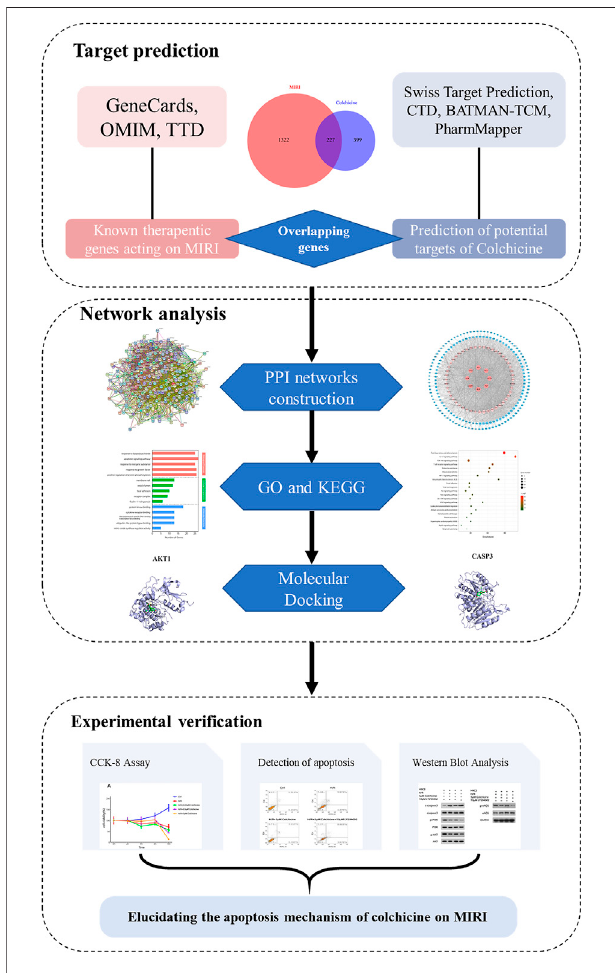
FIGURE 1 | The work fl ow of action mechanism of Colchicine on treating MIRI in this study.